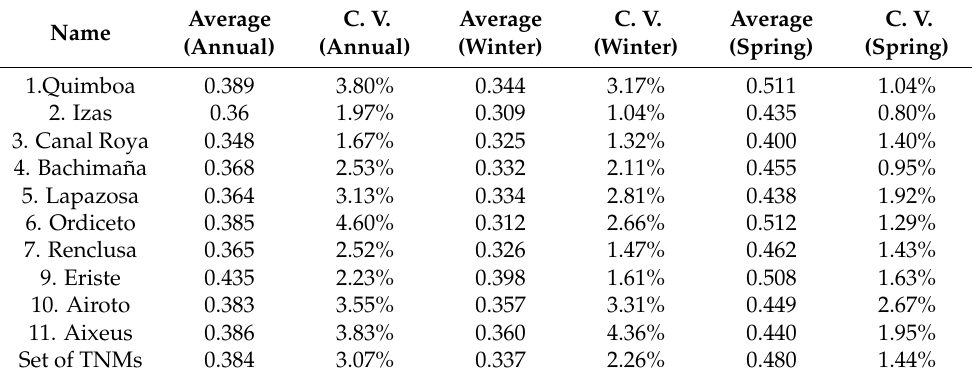
Table 4. SDEN statistics for TNM data and for data from the set of